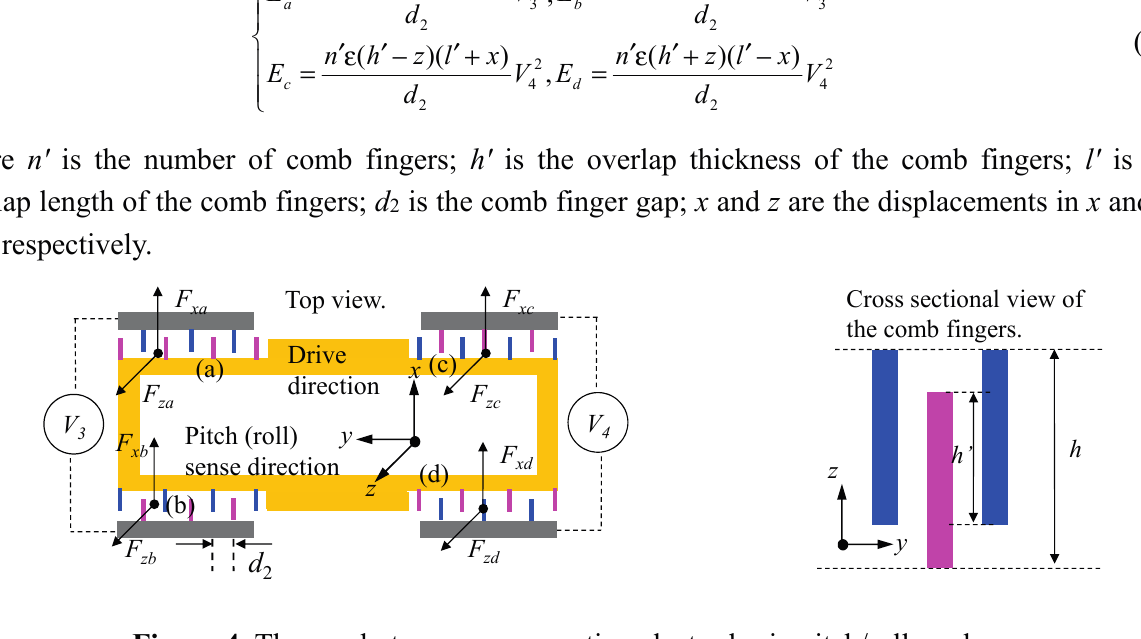
Figure 4. The quadrature error correction electrodes in pitch/roll